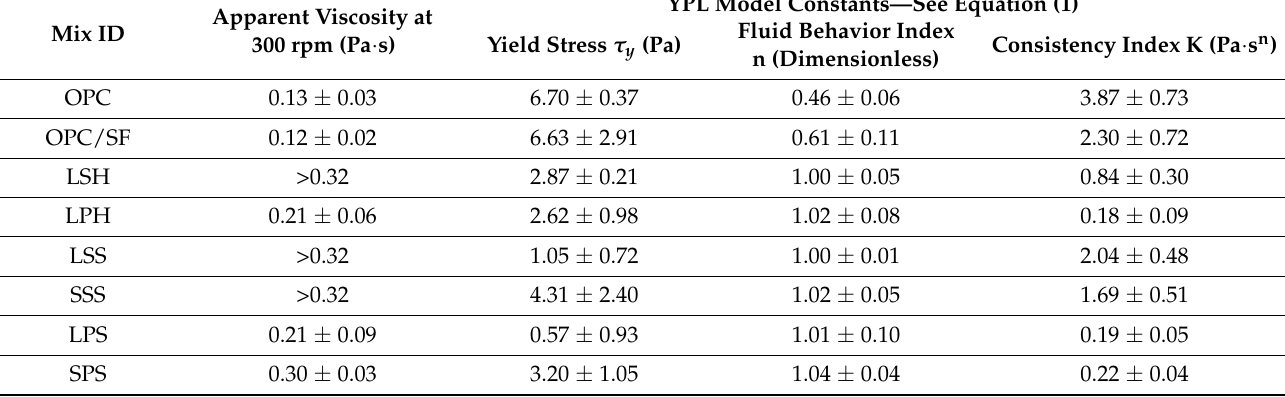
Table 4. Rheological model parameters for OPC and geopolymer slurries.